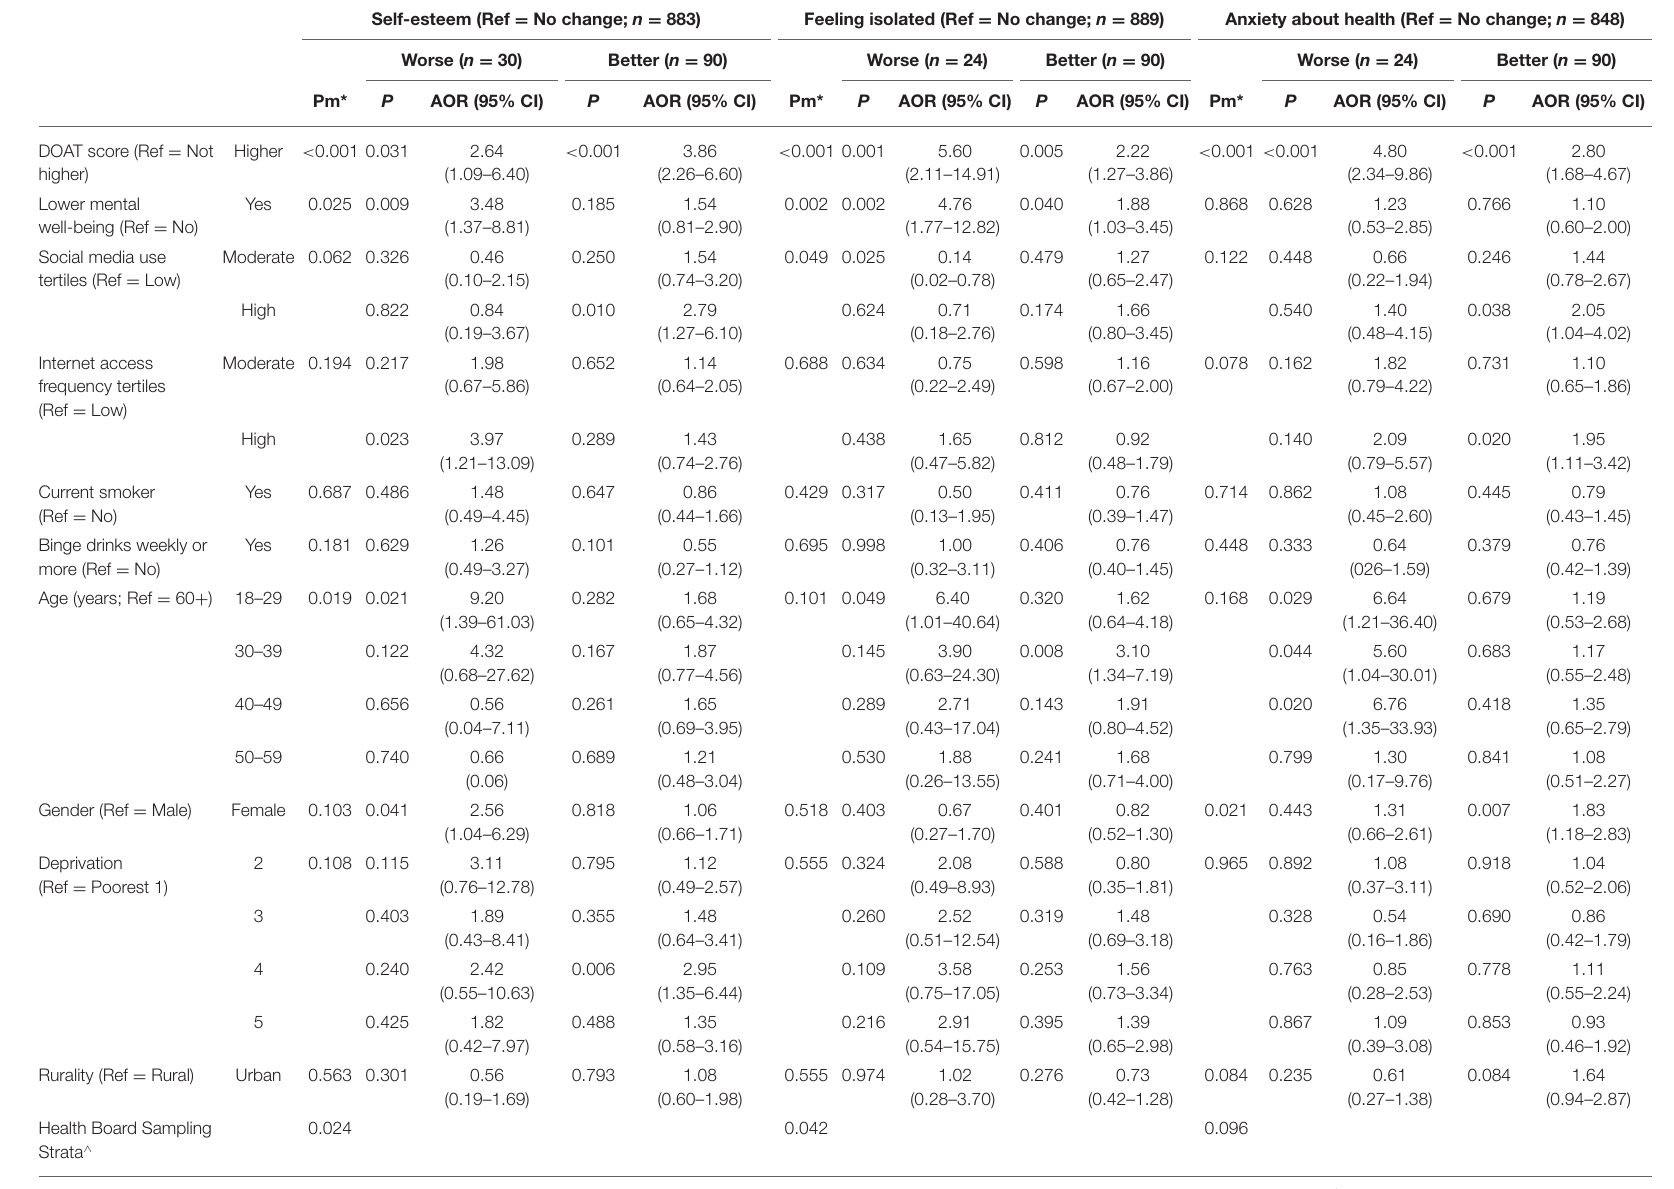
TABLE 4 | Multinomial logistic regression analysis of factors related to mental well-being outcomes when using the internet for health-related